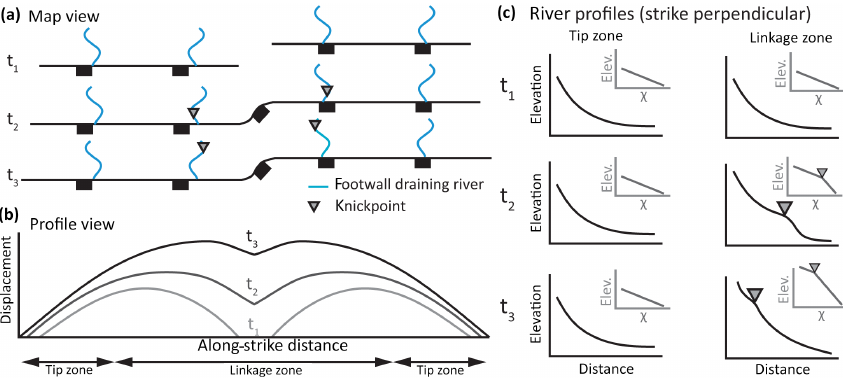
Figure 2. Conceptual model for river profile response to growth and linkage of adjacent normal faults. (a) Map view of linkage history. Knick- points form near the linkage zone due to the rapid increase in uplift rate following linkage of two previously independent faults. (b) Along strike profiles showing the cumulative displacement history resulting from linkage of the normal faults. (c) The predicted response of foot- wall river profiles in the tip and linkage zones. Rivers in the tip zone will experience little change in relative uplift rate, whereas those in the linkage zone will experience a rapid increase in the rate of uplift. The increase in uplift rate will result in the formation of a knickpoint that migrates upstream over time. The knickpoint is identified as a break in slope in a plot of the transformed distance variable, χ , versus